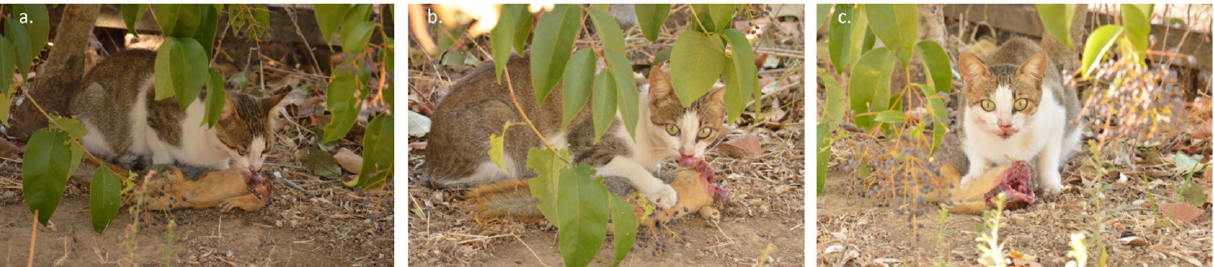
Figure 2. Photographic evidence, from the island of Lesvos, Greece, of a feral cat consuming a full-grown Persian squirrel: ( a ) the moment the cat came into our field of view, ( b , c ) the moment the cat realised our presence.